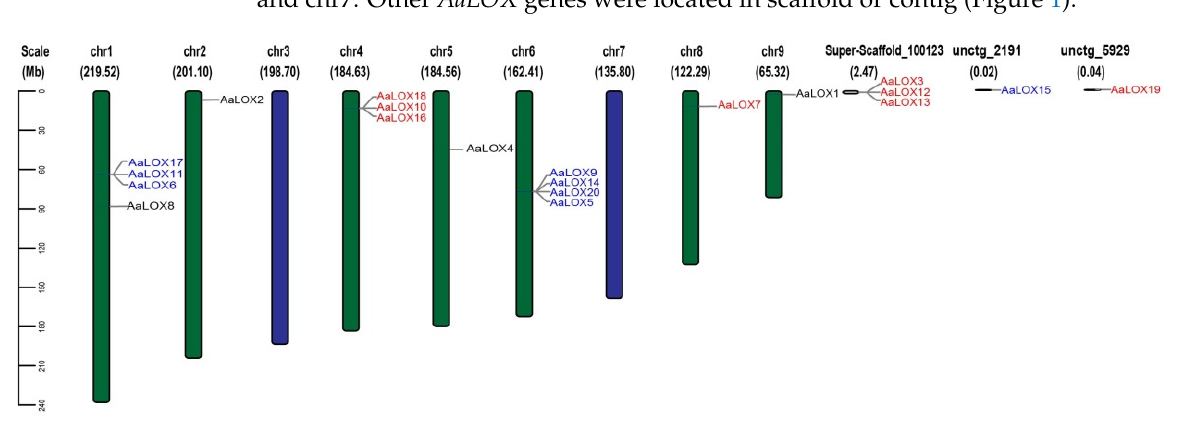
Figure 1. Distribution of AaLOX genes on A. annua . Chromosome names are shown on top of the chromosome and gene names are shown on the right side of the chromosome. According to the phylogenetic tree, the closely related genes are shown in the same color. The chromosomes are indicated by different colors, green for the presence of AaLOX and blue for the absence of AaLOX . The scale bar on the left indicats the length (Mb) of A. annua chromosomes.